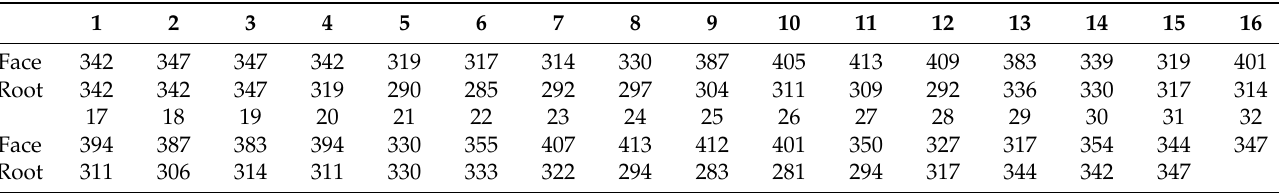
Table 9. Hardness test (HV10) results of GMA-welded S960QL